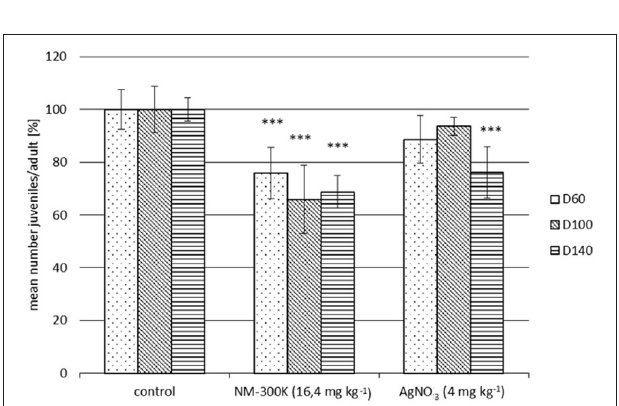
FIGURE 3 | Inhibition of F. candida reproduction in a 28-day test with WWTP-spiked sludge compared to the corresponding sludge control. The sewage sludge was spiked with NM-300K or AgNO 3 which were incorporated into the sludge through a simulated waste water treatment plant. The sewage sludge was applied to soil and incubated for 60, 100, or 140 days before the Collembola reproduction tests were performed. Reproduction per adult is normalized to the corresponding sludge control (100%). Each column represents mean ± SD of 5 replicates. Statistical significances to the respective control: *** p ≤ 0.001.